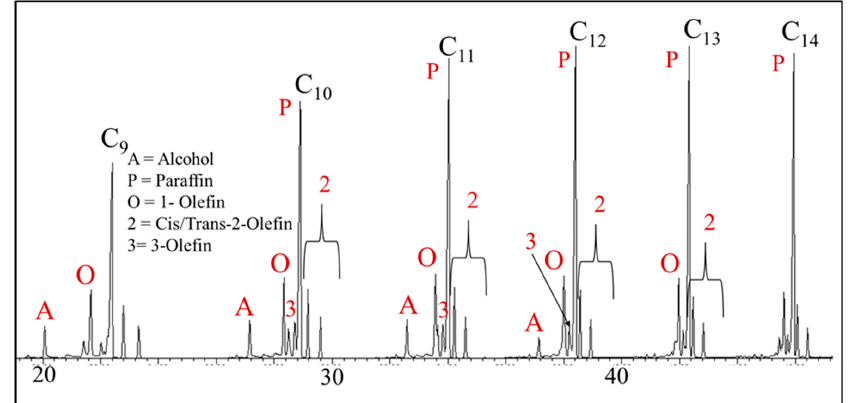
Figure 21. A chromatographic picture of a NaY supported ruthenium catalyst. The x-axis is retention time in minutes. Reaction Conditions: 220 °C, 19.2 bar, WHSV = 1.5, and H 2 /CO = 0.7.